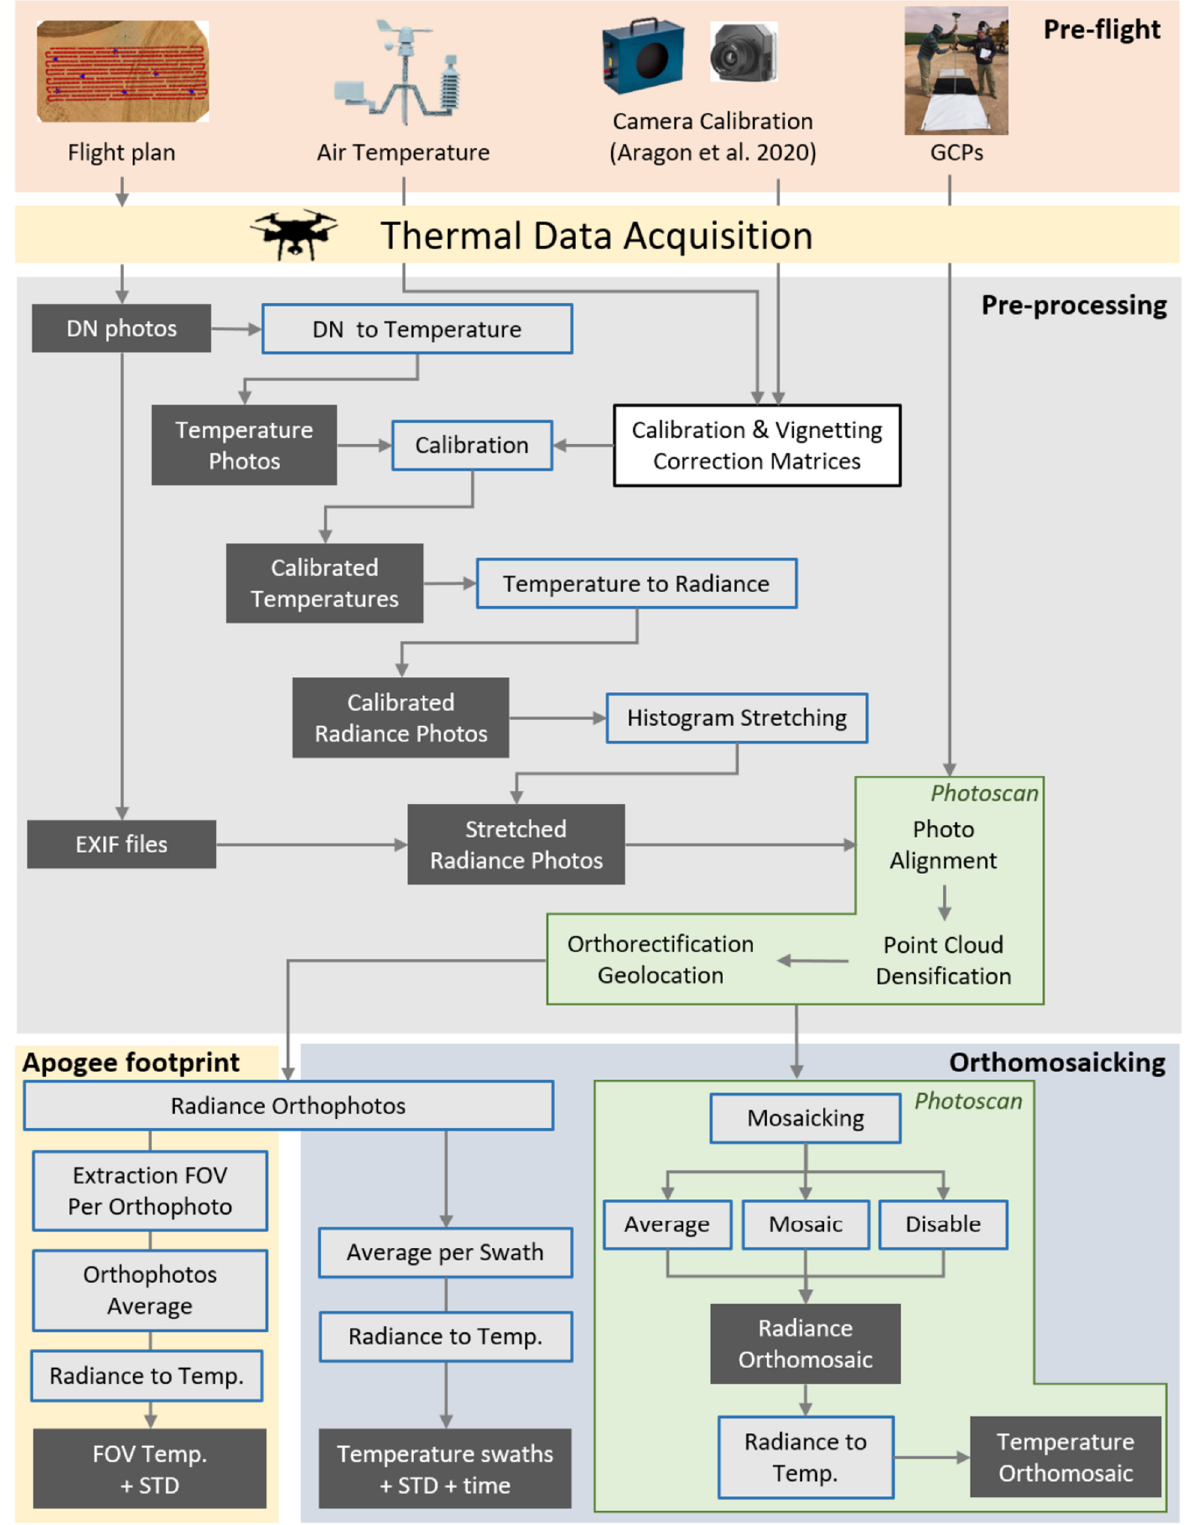
Figure 3. The workflow of the proposed methodology was divided into two main stages, pre-processing and orthomosaic generation. Additionally, the workflow for validation of temperature (temp) within the Apogee field of view (FOV) and standard deviation (STD) assessment is presented in the yellow box.